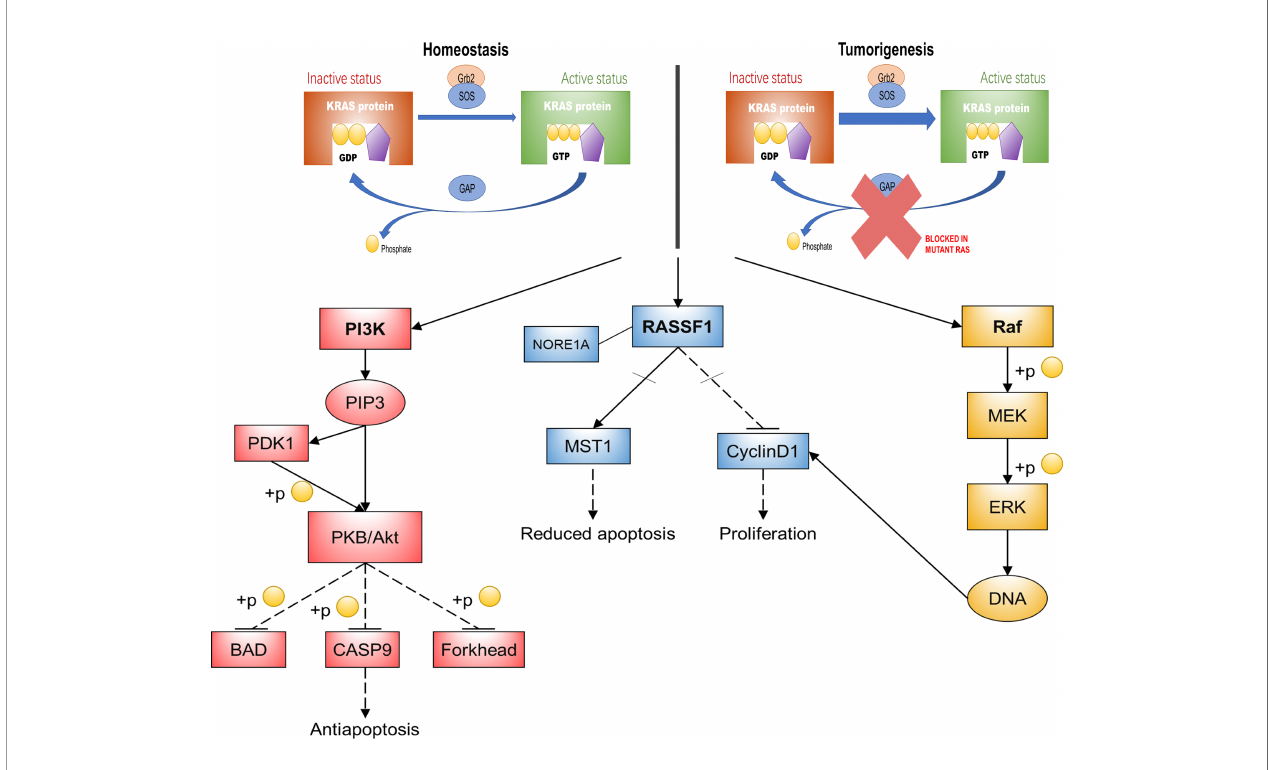
FIGURE 1 | KRAS function and its main downstream pathways. This diagram is a summary of KRAS oncogenic mutations that impair its activity to hydrolyze GTP, thereby activating three major signaling pathways that mediate basic cellular processes. KRAS, kirsten rat sarcoma viral oncogene homolog; Gh2, growth hormone 2; SOS, Son of Sevenless; GTP, guanosine triphosphate; GDP, guanosine diphosphate; GAPs, GTPase-activating proteins; PI3K, phosphoinositide 3-kinase; Akt/PKB, protein kinase B; BAD, BCL-2/BCL-XL-associated death promoter; CASP9, Recombinant Caspase 9; PIP3, phosphatidyl inositol triphosphate; PDK1, 3-phosphoinositide dependent kinase-1; RASSF1, Ras association domain family 1; MST1, human macrophage stimulation 1; Raf, rat fi brosarcoma; MEK, mitogen-activated protein kinase kinase; ERK, extracellular regulated kinase; NORE1A, Ras- association domain family